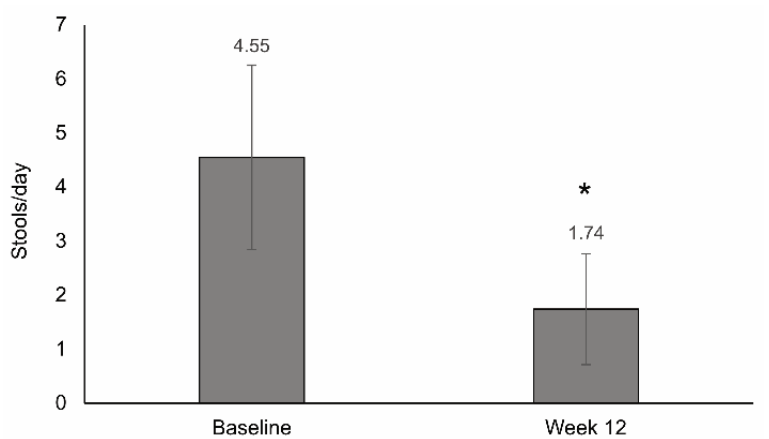
Figure 4. Change in stool frequency after 12 weeks of treatment with a semi-elemental hydrolyzed whey protein diet. Bar graphs show the mean (SD) number of stools per day at baseline and after 12 weeks of treatment; * p < 0.001.